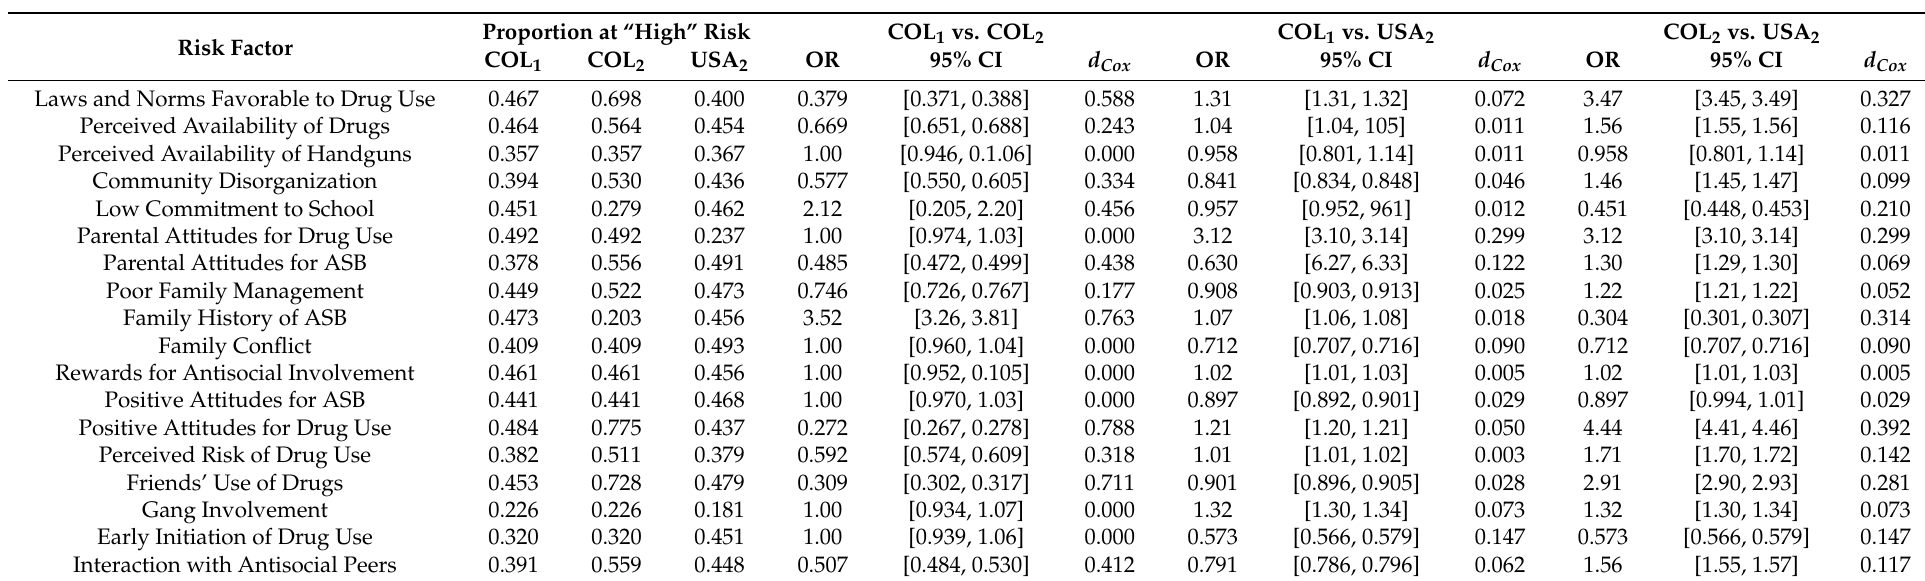
Table 2. Comparison of proportions of eight-grade students at “high” risk, odds ratios, 95% confidence intervals, and effect sizes using Colombian and United States cut points. Risk